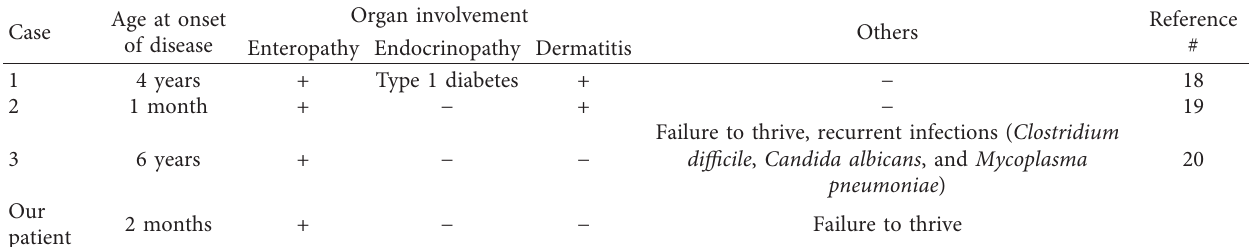
Table 3: Male patients reported with IPEX syndrome with a mutation in FOXP3 gene c.1190G > A (p. R397Q). Age at onset Case of